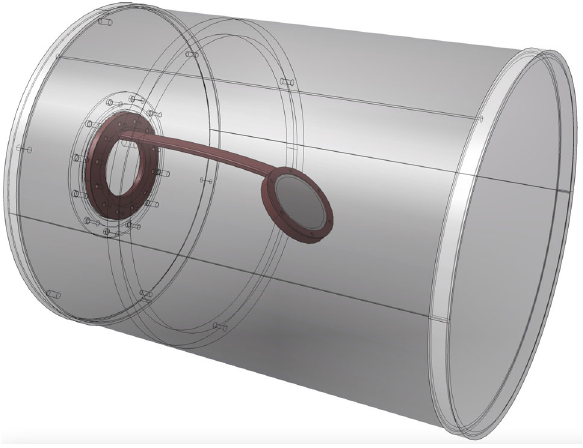
Fig. 8 Drawing of the vacuum chamber with the target support and arms